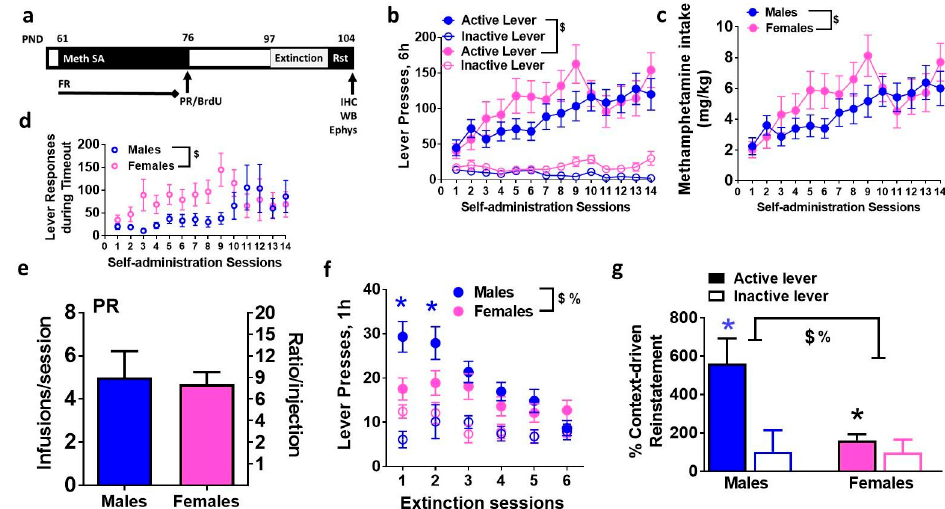
Figure 1. Distinct operant responses during extended access methamphetamine self-administration sessions in male and female rats. ( a ) Schematic of the experimental design indicating the age of animals in days (PND, postnatal days) and sessions during operant behavior. FR, fixed-ratio schedule; PR, progressive-ratio schedule; Rst, reinstatement; IHC, immunohistochemistry; WB, Western blotting; Ephys, electrophysiology. ( b ) Active and inactive lever responses of male and female rats self-administering 0.05 mg/kg/infusion of methamphetamine. ( c ) Total amount of methamphetamine consumed per session. ( d ) Active lever responses during timeout period during each session. ( e ) Lever responses during PR sessions. ( f ) Active and inactive lever responses during extinction